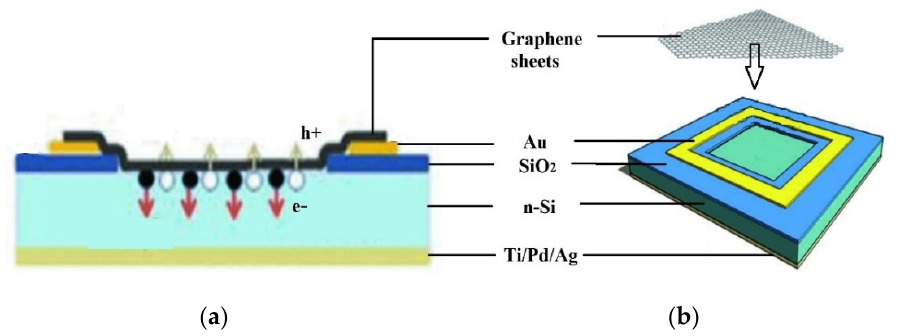
Figure 18. Graphene–silicon Schottky junction solar cell. ( a ) Cross-sectional view, ( b ) schematic illustration of the device configuration [75].